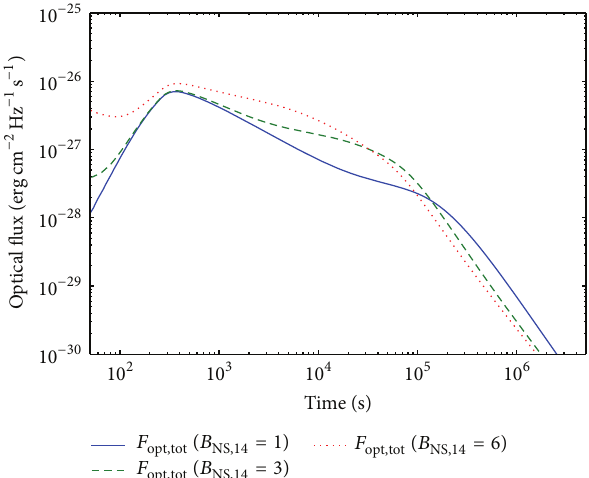
Figure 6: Optical lightcurves in the electron-positron wind model with different 𝐵 NS . All the parameters are the same as those in Figure 5, except for 𝐵 NS ,14 = 1 (solid line), 𝐵 NS ,14 = 3 (dashed line), and 𝐵 NS ,14 = 6 (dotted